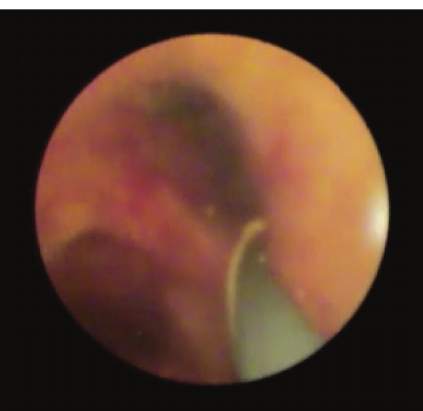
Figure 3: Direct view cholangioscopy enabling the adequate place- ment of guidewire through a biliary